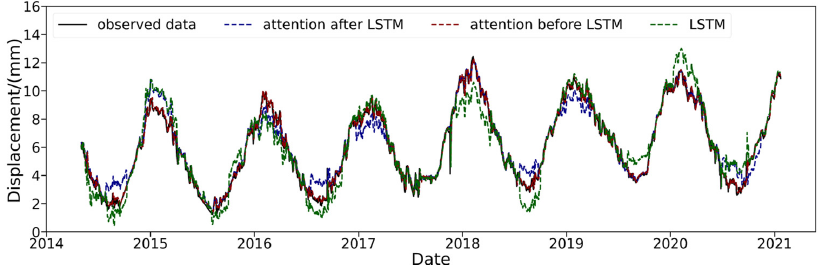
Figure 12. Predictive fitting curve of the LSTM and coupled models.